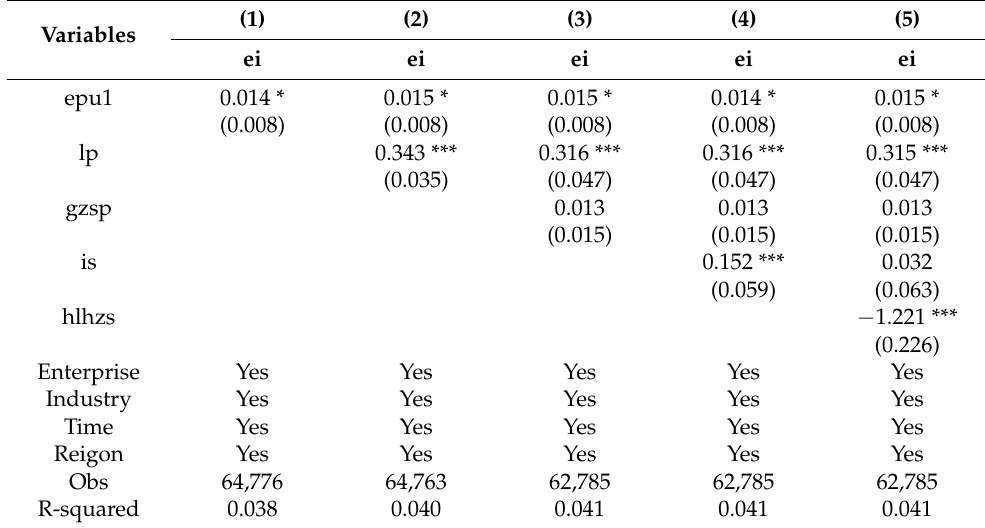
Table 7. Change the core explanatory variable—environmental policy